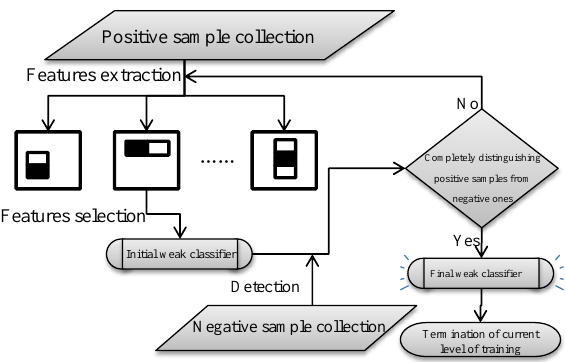
Figure 1. Flow chart of every level of classifier